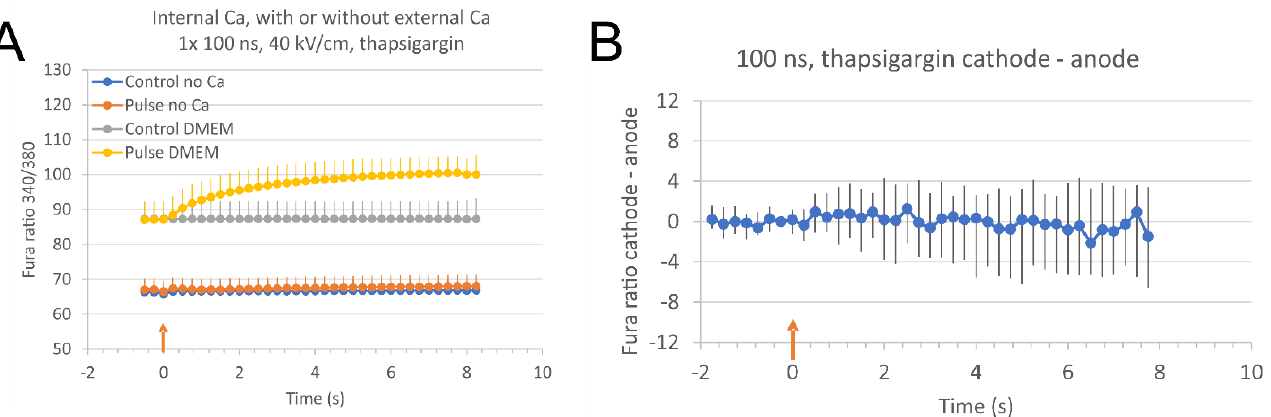
Figure 6. The exposure of cells incubated with 100 nM thapsigargin (for 30 min) to a single 100 ns, 40 kV/cm pulse in media with (DMEM) or without Ca 2+ ions (SMEM and EGTA). Relative calcium concentration in H9c2 cells was monitored with a fluorescent calcium indicator Fura-2 and expressed as Fura-2 ratio 340/380 over time. Image acquisition was done every 250 ms. ( A ): Relative calcium concentration in all cells exposed to a single 100 ns pulse in different media. Results are presented as mean ± SD from ten (no Ca 2+ ) or 14 (DMEM) experiments (3–11 cells per experiment analyzed). Controls are experiments without pulse application. ( B ): Fura ratio difference between cathode and anode in thapsigargin treated cells (both parallel and perpendicular cells together) after electroporation with a single 100 ns, 40 kV/cm in medium with Ca 2+ ions (DMEM). Results are presented as median from cells (only parallel and perpendicular cells) pooled from 14 experiments (12–30 cells analyzed), vertical bars represent Q1 and Q3. Time of pulse application is noted with a red